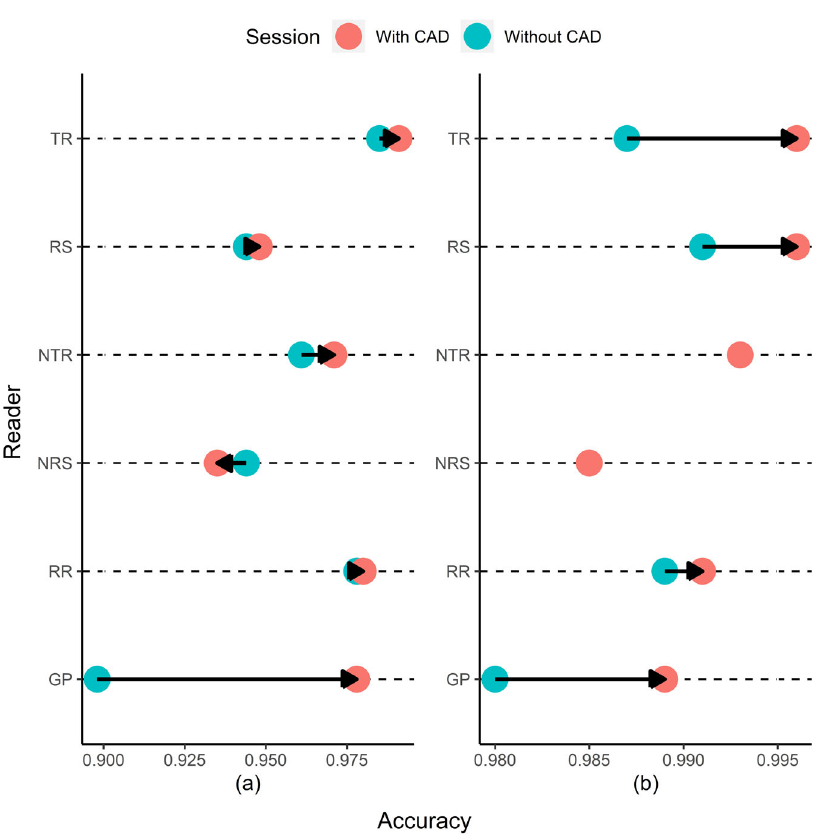
Fig. 2 Individual readers ’ diagnostic accuracy with and without the CAD assistance in the impact trial. The accuracies are separately presented for a consolidation and b pneumothorax. The red circle represents accuracy with the CAD assistance, and the blue circle represents accuracy without the CAD assistance. The arrow indicates a directional change in the accuracy when the CAD was used. Raw values are presented in Supplementary Table 3. CAD Computer-aided detection system, TR Thoracic radiologist, RS Respiratory specialist, NTR Non- thoracic radiologist, NRS Non-respiratory specialist, RR Radiology resident, GP General